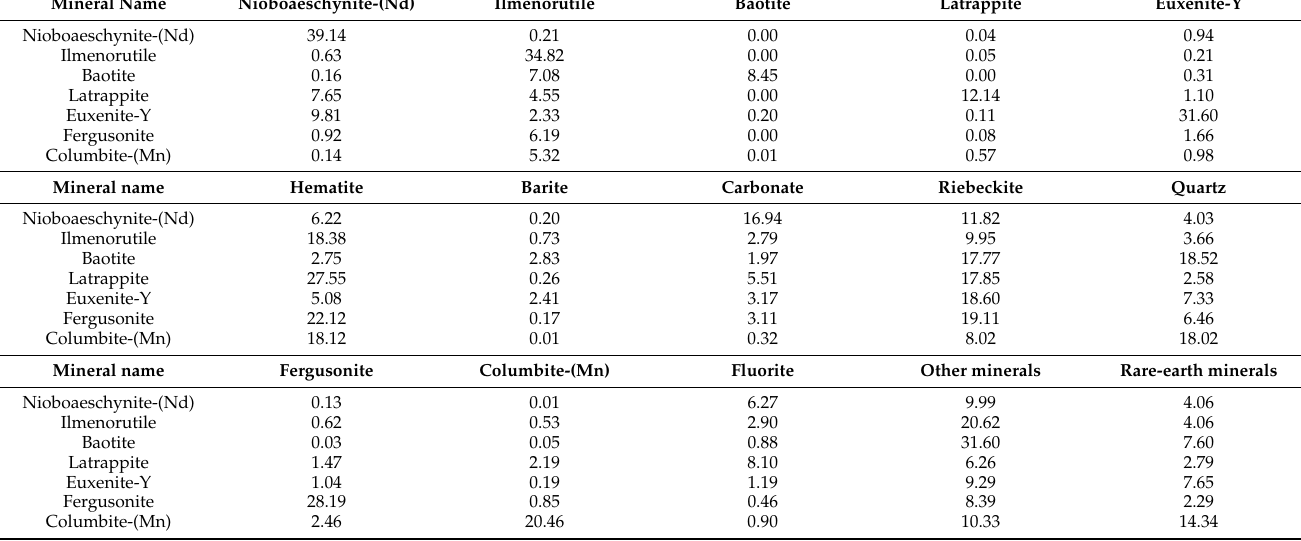
Table 6. Liberation degree of important niobium minerals in Nb-bearing minerals